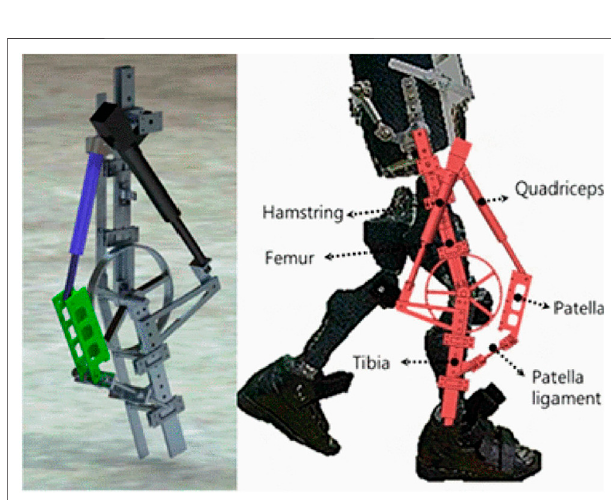
FIGURE 5 | Knee joint actuation mechanism for gait rehabilitation exoskeleton (Pyo et al., 2010).